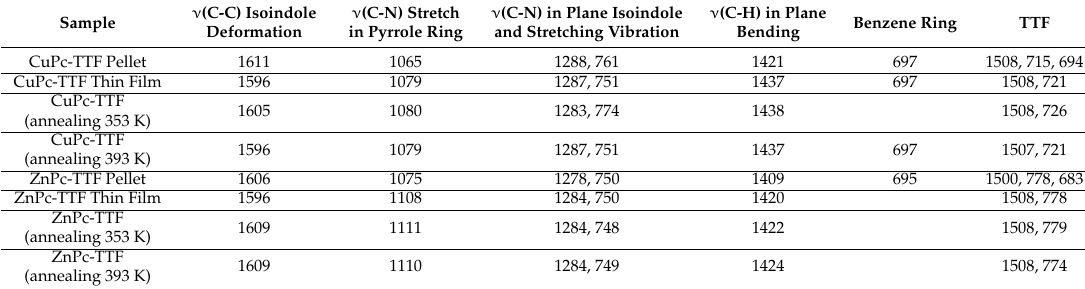
Table 1. Characteristic FT-IR signals for TTF-MPcs (M = Cu, Zn) in pellets and thin films (cm ´ 1 ). Sample